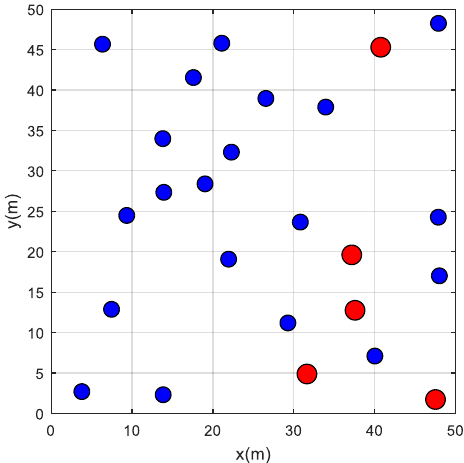
Figure 2. Plot of reference and target nodes for case 1.